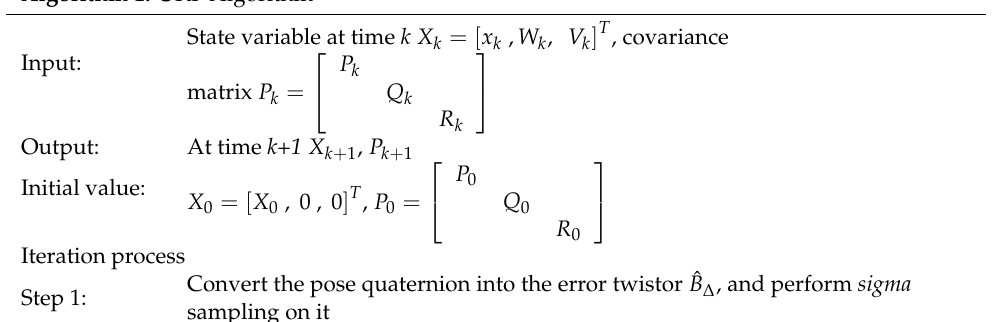
Algorithm 1. UKF